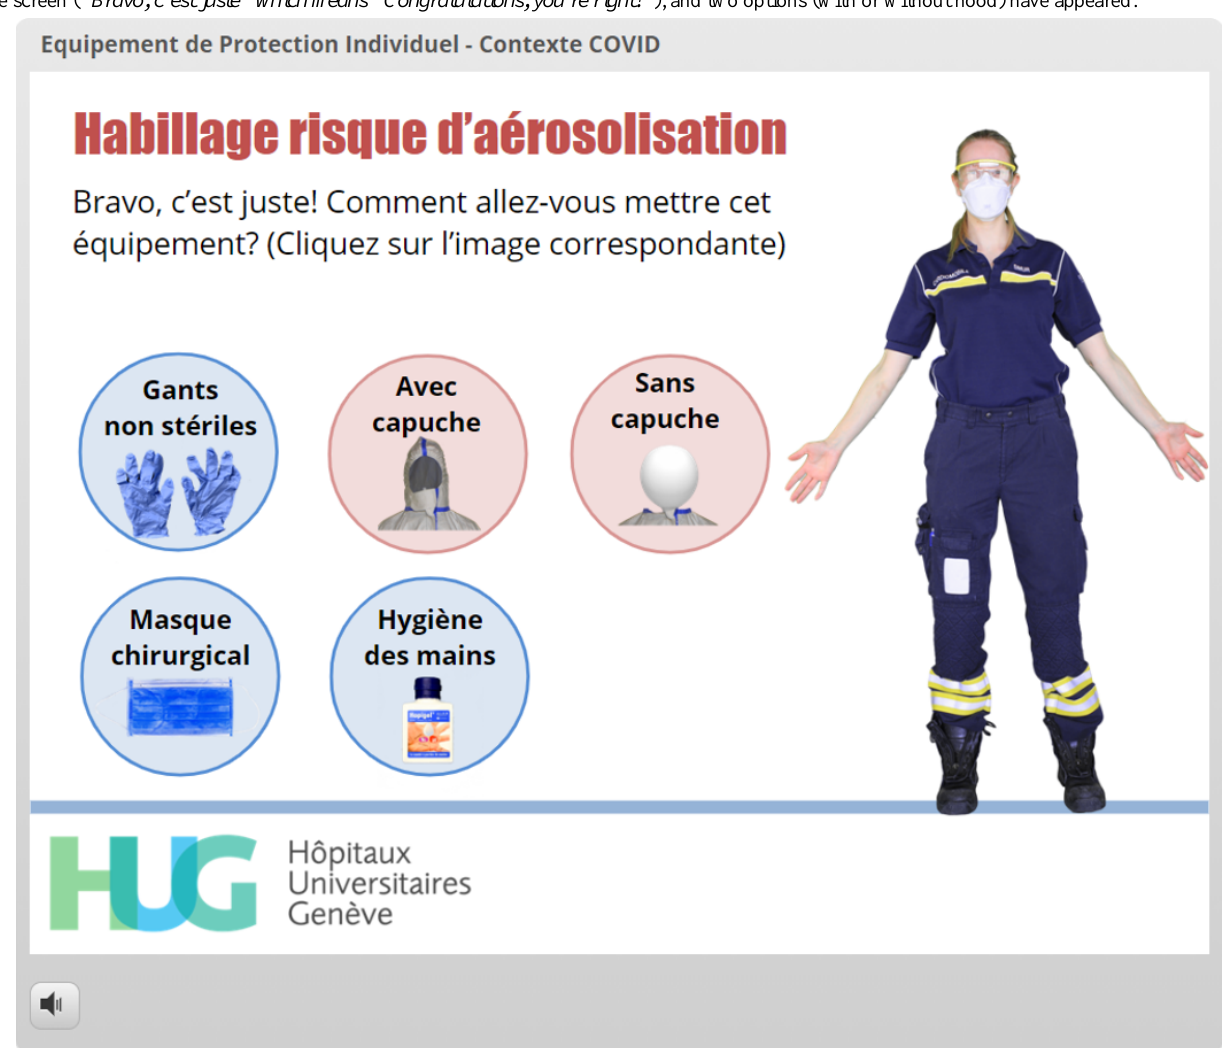
Figure 11. The learner has now decided to put on the overalls, which is the right answer at this stage. The positive feedback is displayed at the top